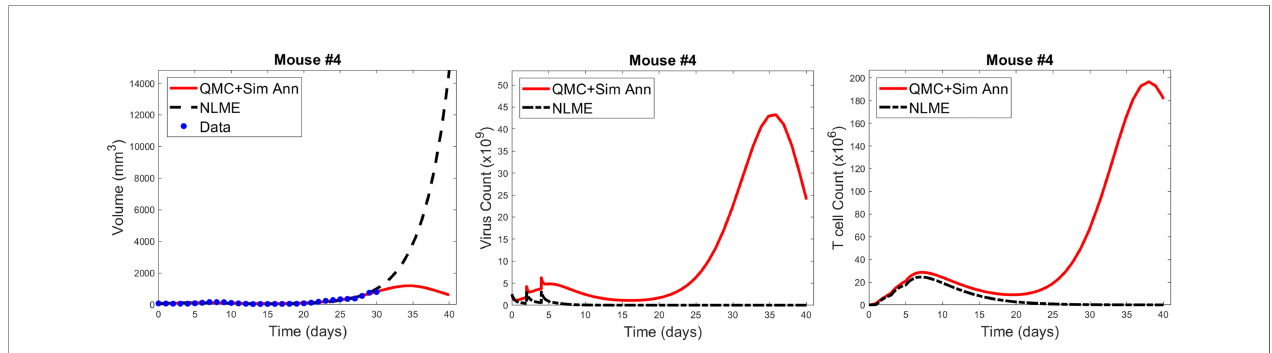
FIGURE 7 | Left: QMC and NLME-associated fi ts to Mouse 4 treated with VDVDVD, with model predictions extended 10 days beyond the data-collection window. Center and right: Predicted virus and T cell counts associated with each fi tting methodology,